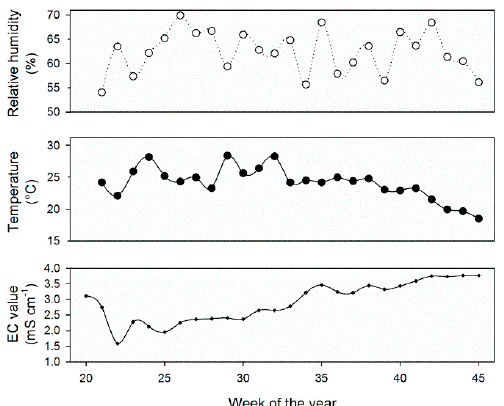
Figure 3. Weekly mean values for temperature (T), and relative humidity (RH) in the greenhouse,